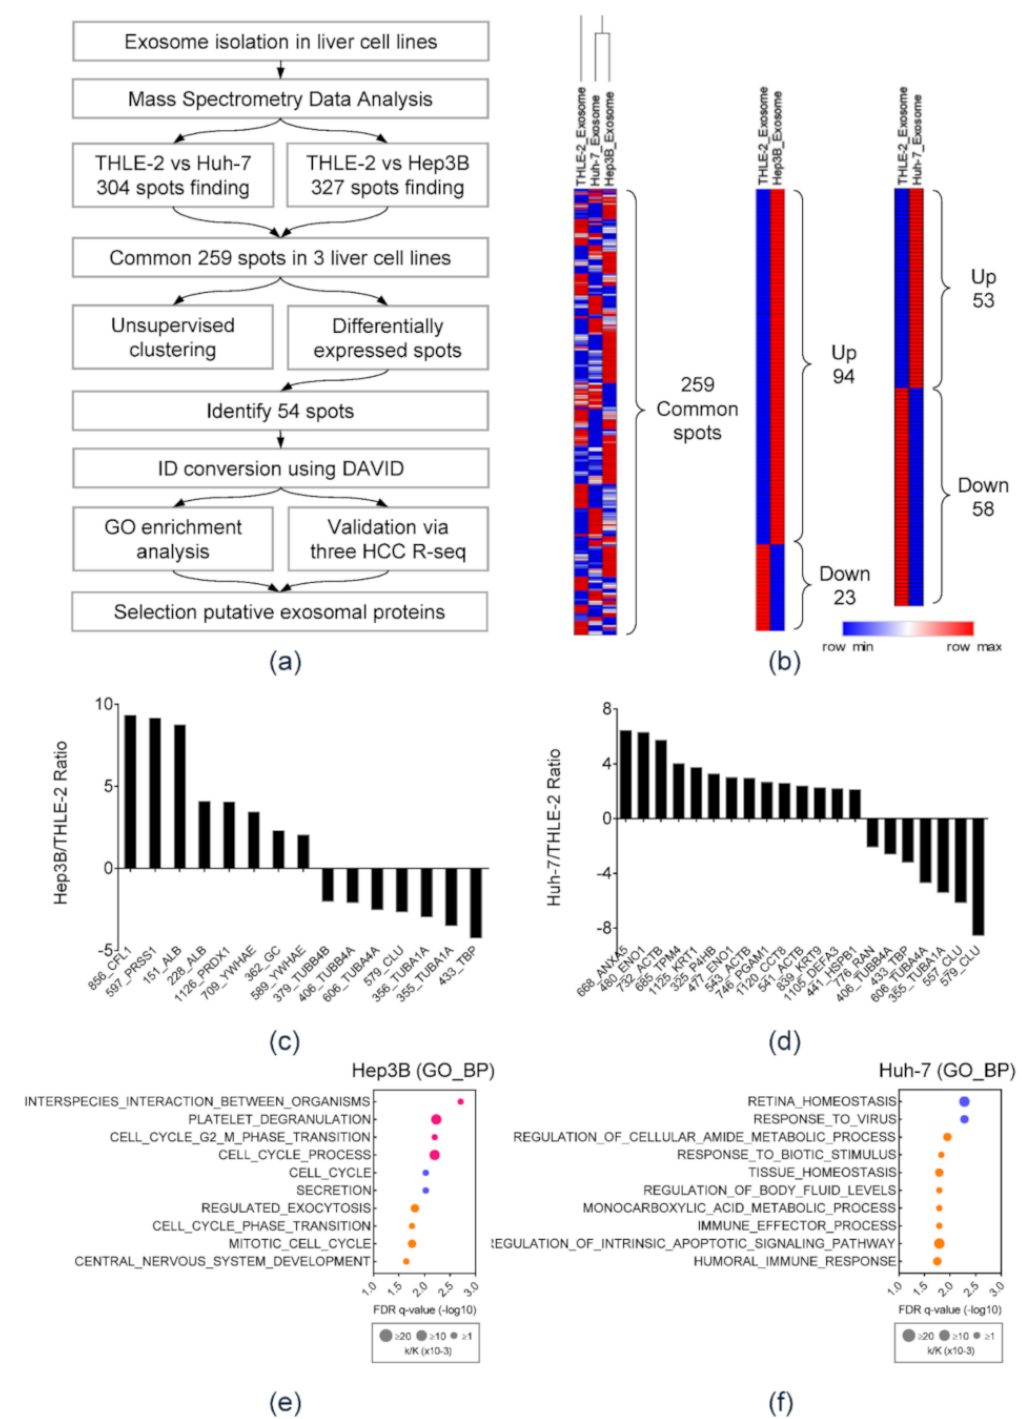
Figure 2. Identification of exosomal protein markers in HCC. ( a ) A schematic view of the procedure to find novel exosomal protein markers in HCC. ( b ) Heat map depicting differentially expressed protein spots in each cell line. ( c ) The expression ratio of differentially identified exosomal proteins in Hep3B as compared to THLE-2. ( d ) The expression ratio of differentially identified exosomal proteins in Huh-7 cell lines as compared to THLE-2. ( e , f ) GO enrichment analysis of exosomal proteins specific in ( e ) Hep3B and ( f ) Huh-7 cell lines. The top 10 significantly enriched GO categories were under biological